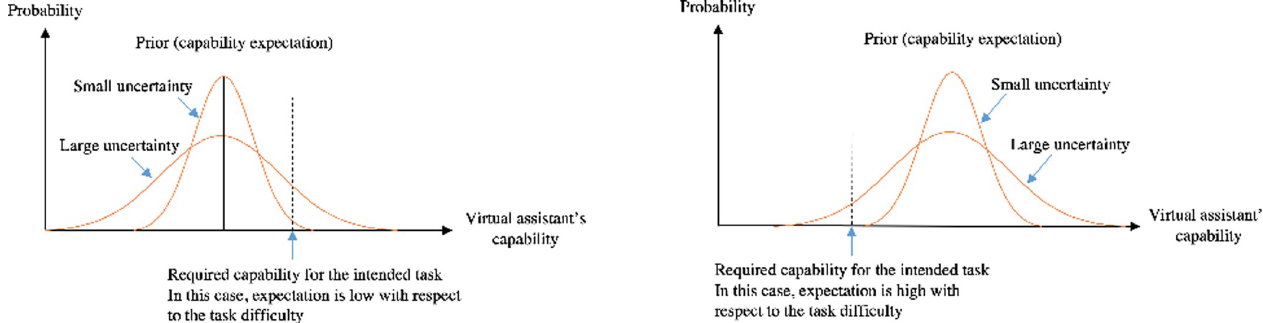
Fig 2. a. Hypothesis on uncertainty. A supposedly difficult task “intersects” with the large uncertainty prior distribution at higher probability than when uncertainty is small. When the expectation is low, it is more rational to expect an assistant exhibiting large uncertainty to perform better than it usually does. b. Hypothesis on uncertainty. A supposedly easy task “intersects” with the large uncertainty prior distribution at higher probability than when uncertainty is small. When the expectation is high, it is more rational to expect that an assistant exhibiting large uncertainty may fail to cope with easy tasks.